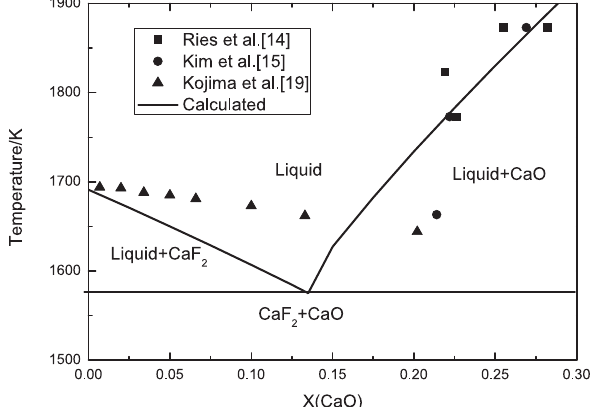
Fig. 3: Comparison between calculated CaO-CaF 2 phase diagram and experimental phase